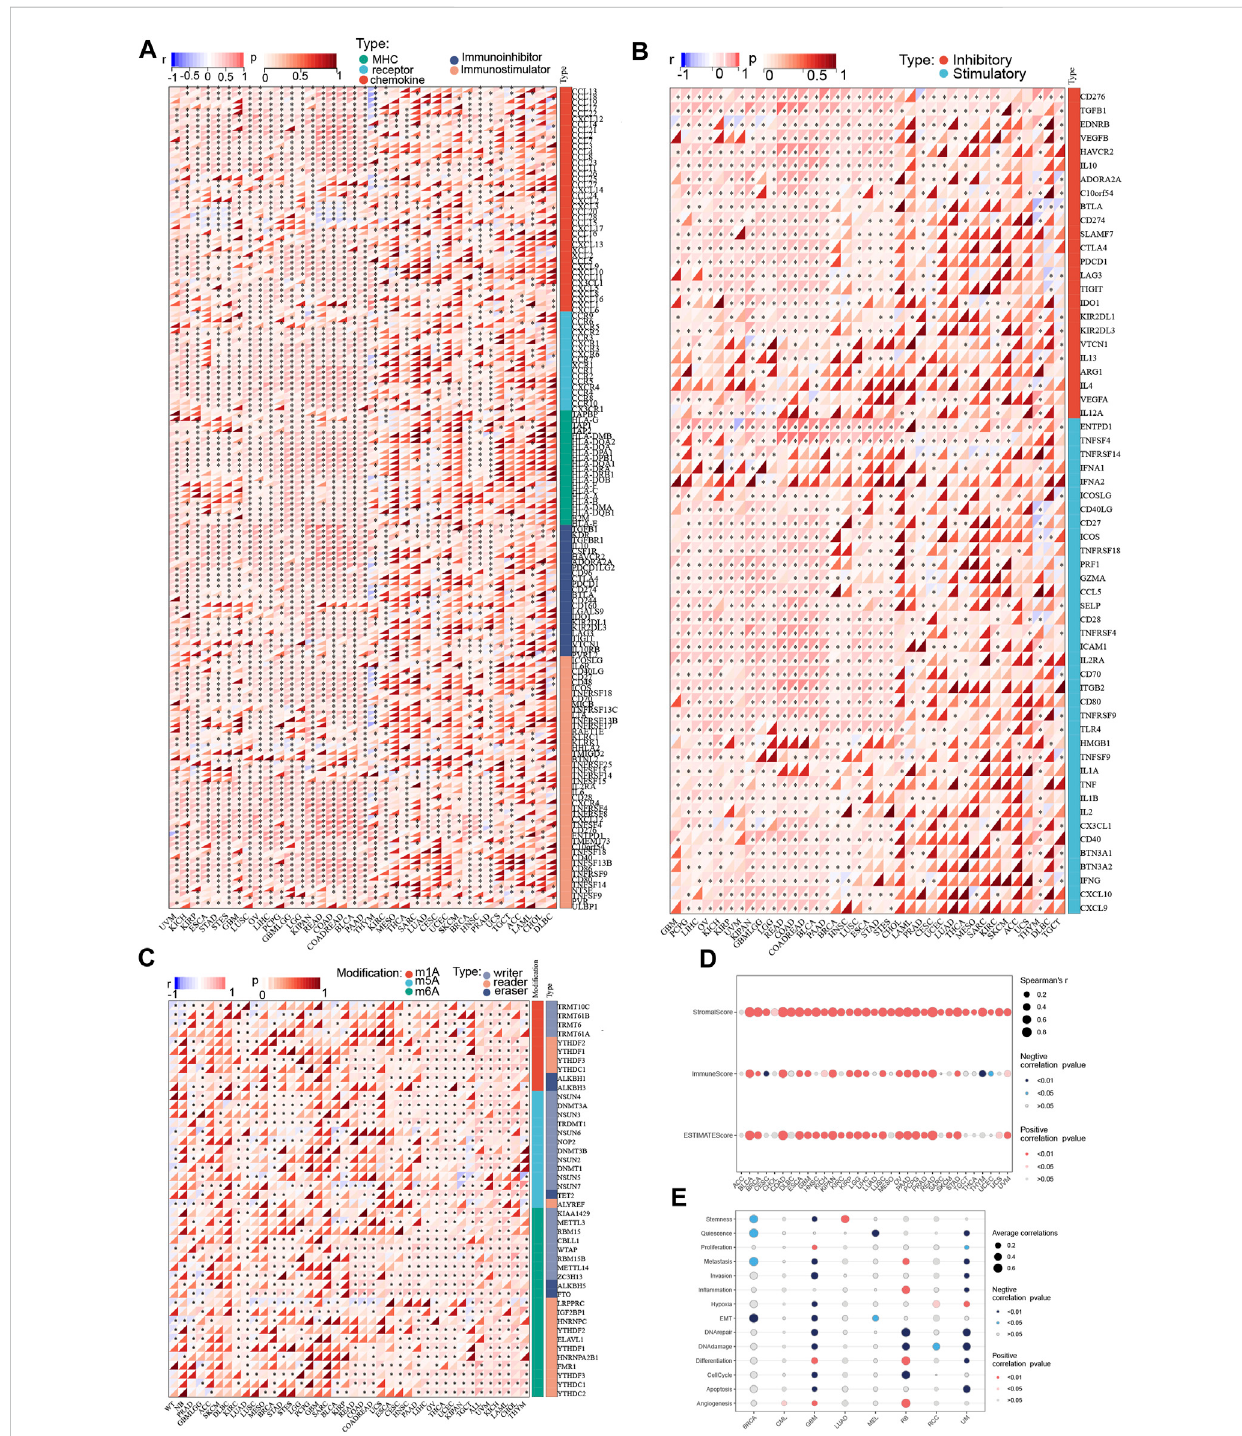
FIGURE 7 Co-expressionof P4HA3 withimmune-associatedgenes.Co-expressionbetween P4HA3 and (A) Immunoregulatorygenes (B) Immunecheckpoint genes, and (C) RNA modi fi er genes (* p < 0.05, ** p < 0.01, and *** p < 0.001). The Relationship of P4HA3 expression with (D) immune in fi ltration and (E) cancer related functional status